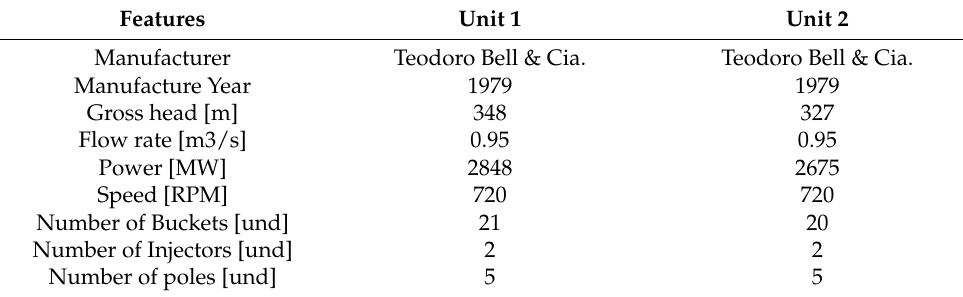
Table 1. Specifications of the generation units.